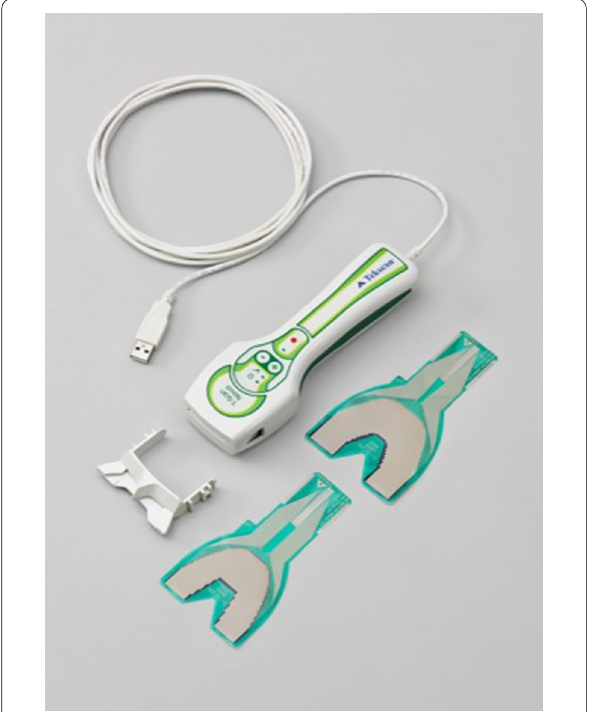
Fig. 1 T-Scan device and the